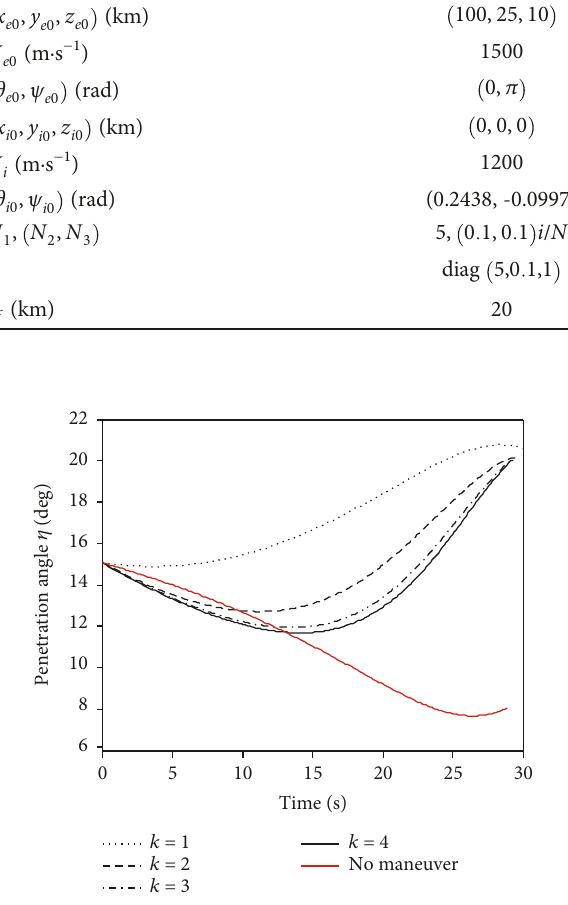
Figure 3: Penetration angle in the fi rst four successive iterations of the SOCP-based algorithm.